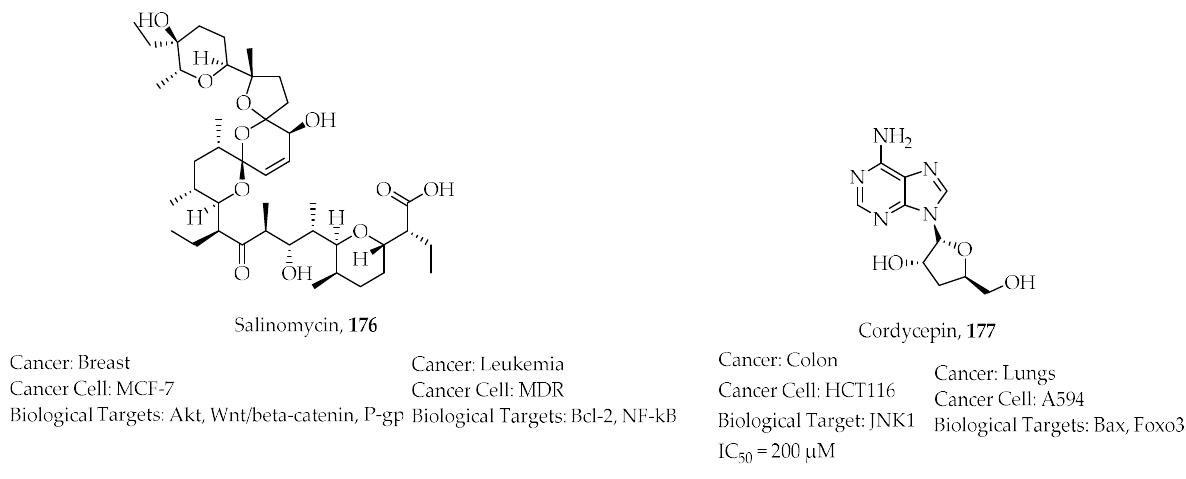
Figure 45. Structures of the monocarboxylic polyether Salinomycin and the nucleoside antimetabolite Cordycepin with a summary of their biological activity towards selected cancer targets.